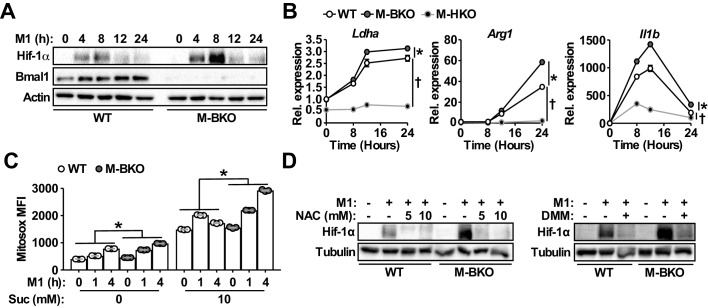
Bmal1 loss-of-function increases oxidative stress and Hif-1α protein accumulation.(A) Immunoblots of Hif-1α and Bmal1 protein levels in WT and M-BKO macrophages during a 24-hr time course of M1 activation. (B) Relative expression of Hif-1α target genes in WT, M-BKO and M-HKO macrophages determined by qPCR. N = 3 biological replicates, statistical analysis was performed using two-way ANOVA for WT vs M-BKO or WT vs M-HKO across the time course. (C) Measurement of mROS using MitoSox Red (mean fluorescence intensity, MFI) in mitochondria isolated from control or M1-activated macrophages. Succinate (Suc, 10 mM) was included during MitoSox Red staining where indicated. N = 3 biological replicates, statistical analysis was performed using two-way ANOVA for WT vs M-BKO across the time course. (D) Hif-1α protein levels in control or 8-hr M1-activated macrophages co-treated with or without N-acetylcysteine (NAC) or 10 mM dimethylmalonate (DMM). Data are presented as mean ± S.E.M. *, p<0.05 for WT vs M-BKO and p<0.05 for WT vs M-HKO. Experiments were repeated at least twice.